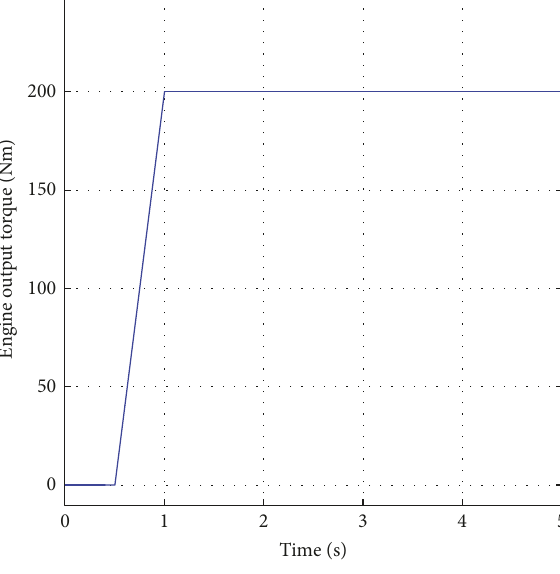
Figure 6: Engine output